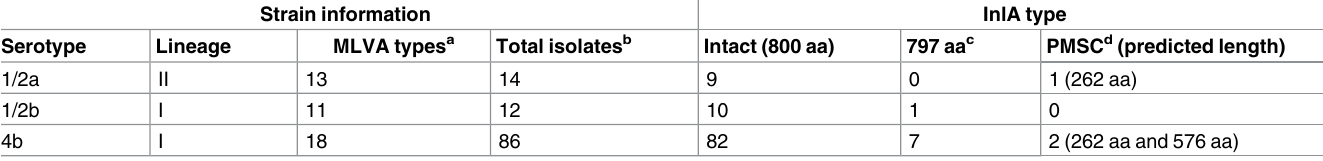
a The number different MLVA types detected among the isolates of the designated serotype b The total number of isolates of the designated serotype